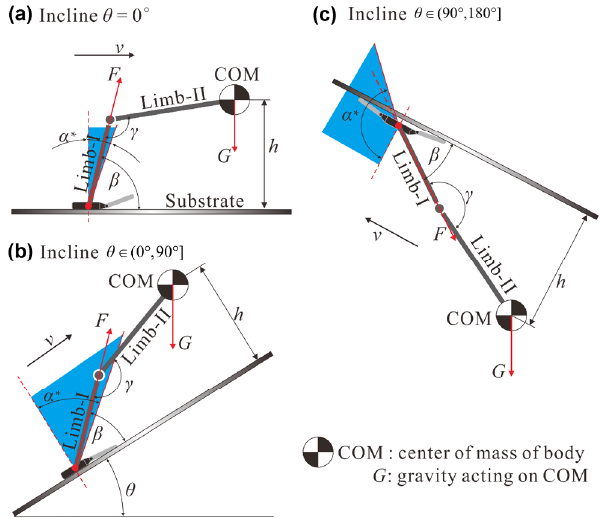
Fig. 8 Contact state of the foot and adjustment of the position in response to the incline. (a) Critical angle ( α * ) of the foot and the position of the gecko limb on a horizontal substrate. (b) α * of the foot and the position of the gecko limb on inclines of less than 90°. (c) α * of the foot and the position of the gecko limb on inclines greater than 90°. The limb is simplified to two parts, limb-I and limb-II, with limb-I being closest to the foot. β : angle between limb-I and the substrate; γ : angle between limb-I and limb-II; h : distance between COM and the substrate; F : force acting on